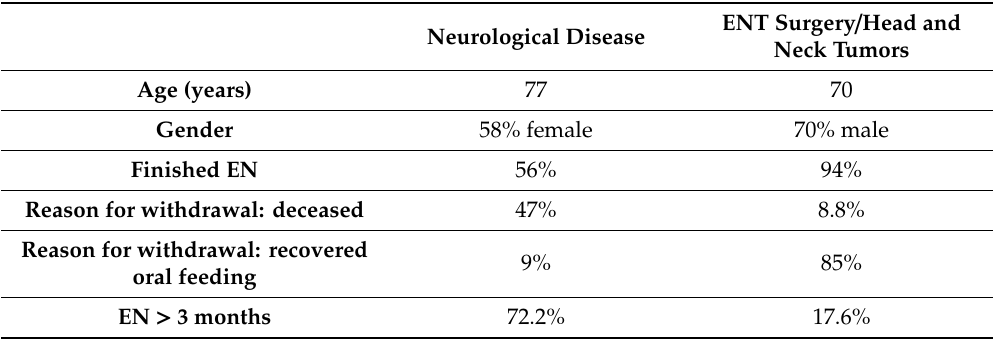
Figure 1. Diagnoses of patients requiring home enteral nutrition (HEN). Table 1. Characteristics by pathology. ENT, ear, nose, and throat; EN, enteral